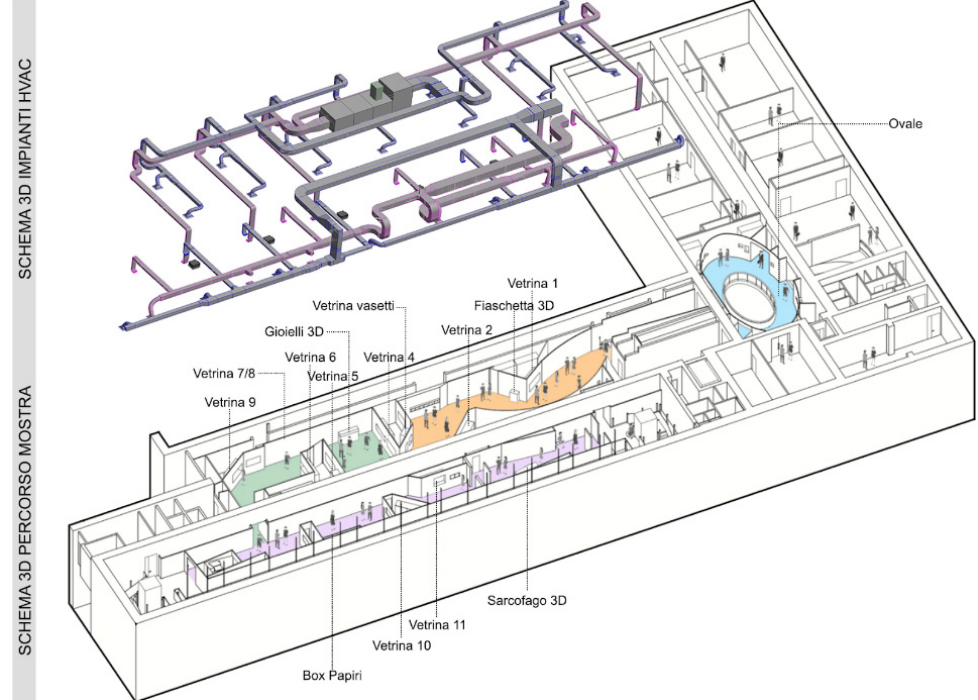
Figure 8. Overlapping of the architectural and plant models. “Invisible Archaeology” temporary exhibition. Exploded axonometric view made by Arch. M. Cammarano.